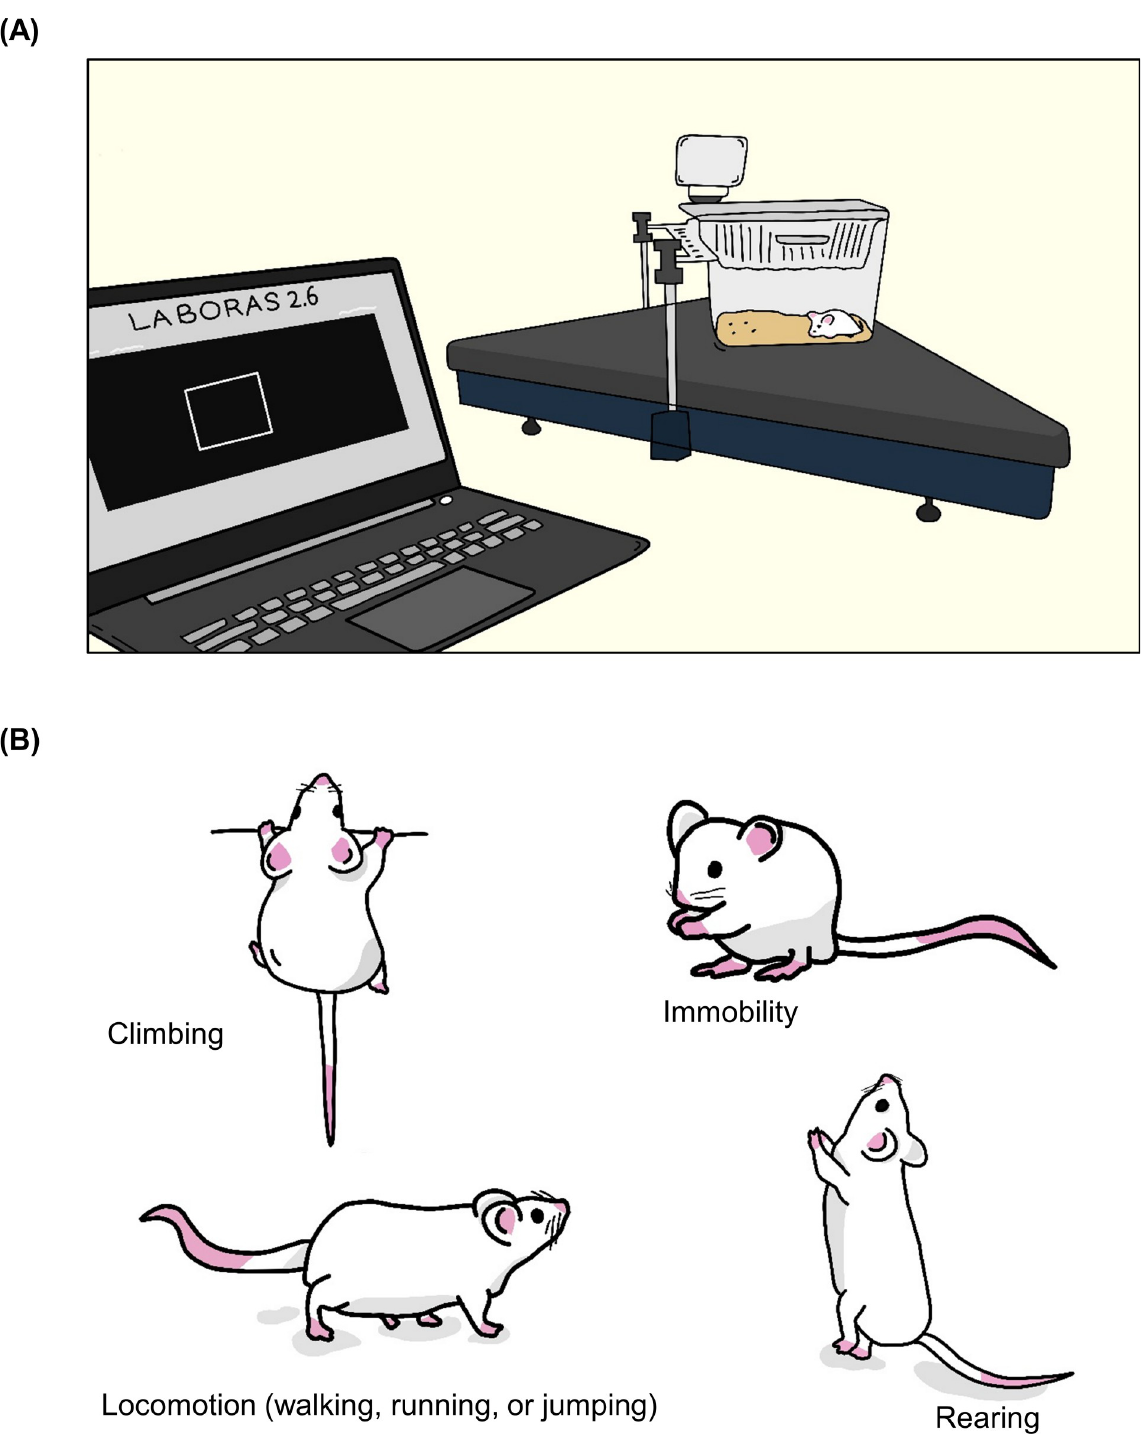
Fig 3. Schematic representation of the experimental setup. (A) The LABORAS consists of cages connected to the LABORAS control unit (LCU) and computer. (B)The behaviors read by the automated home-cage LABORAS system.